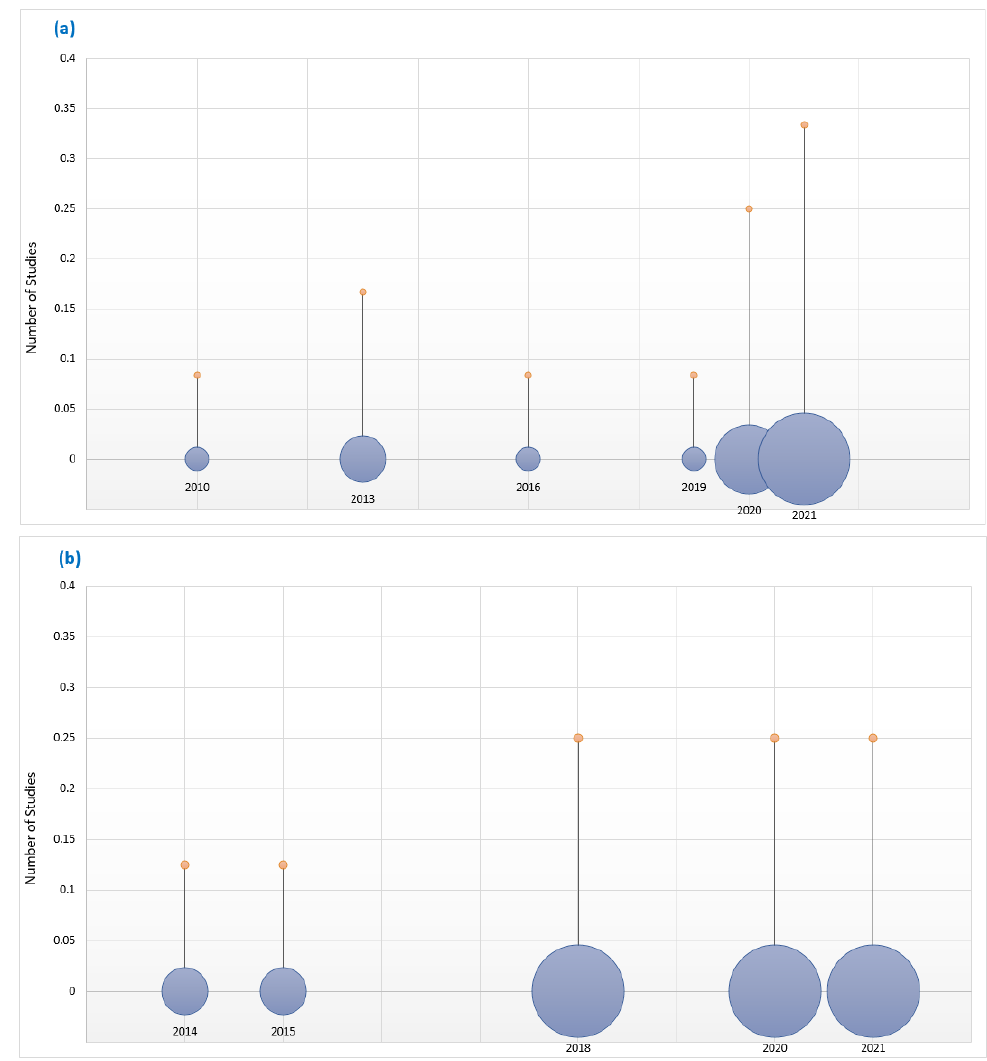
Figure 1. Growth of ( a ) bioacoustics and ( b ) general acoustics research over the